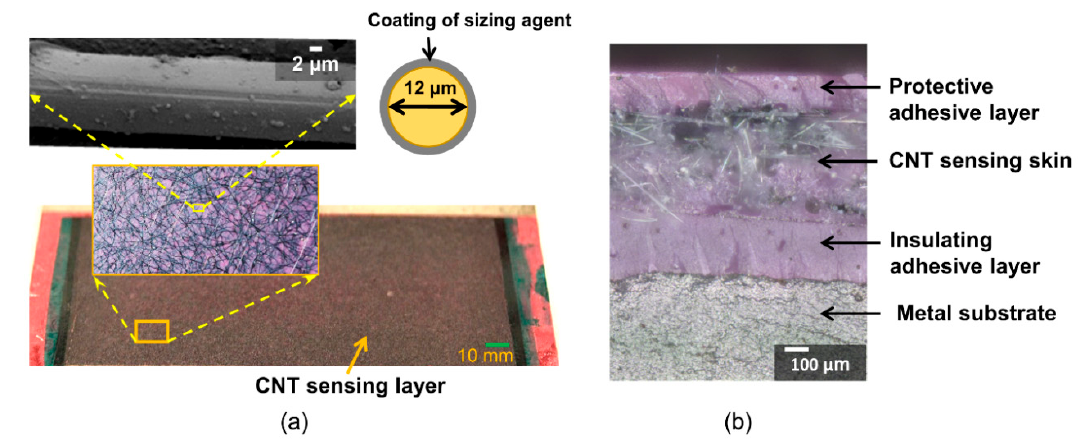
Figure 3. ( a ) Images of CNT fatigue sensor bonded to metal substrate; insets show network of CNT-coated aramid fibers, typical CNT-coated aramid fiber, and schematic of its cross-section; ( b ) photo of interface between sensing layer and metal substrate (before application of silicone paste).